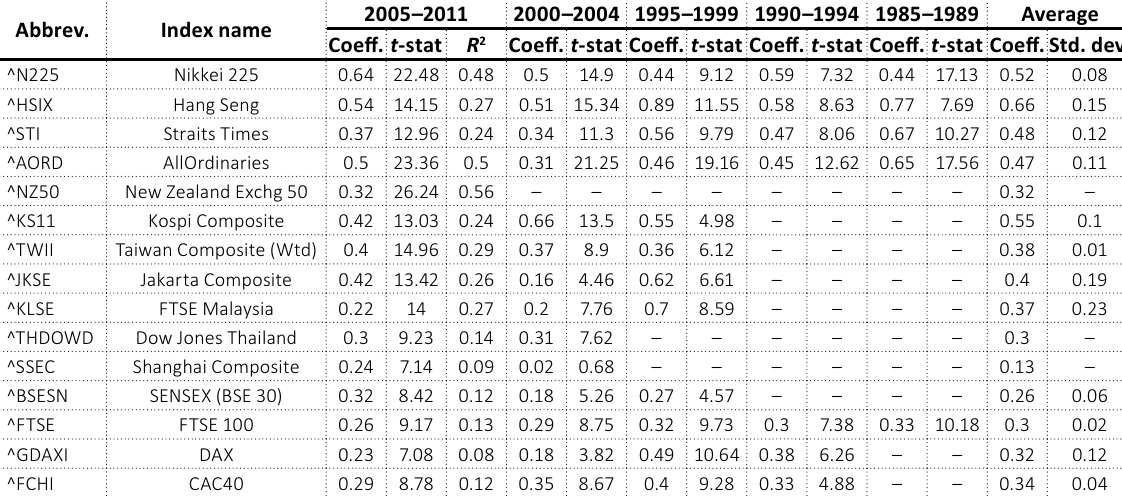
Table 3. Regression coefficients (or betas) for regressing the foreign index daily returns on the